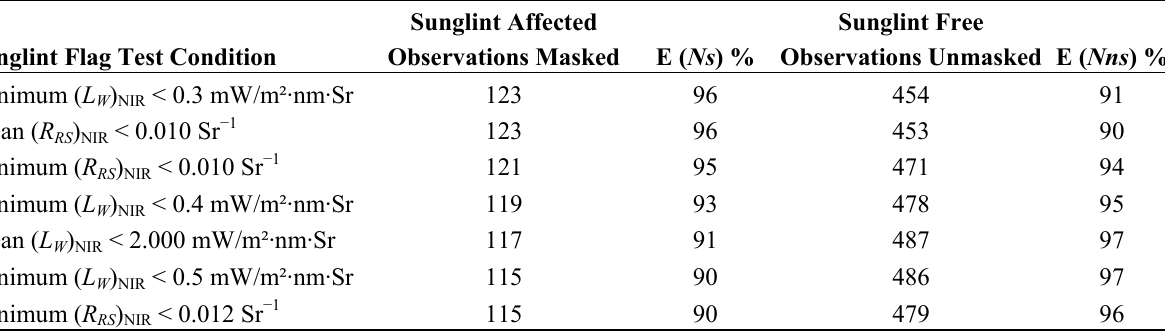
Table 1. A summarized evaluation of the most effective sunglint flagging ranked according to their performance in masking sunglint spectra in a reanalysis. To check for effectiveness, the percentage E ( Ns ) % and E ( Nns ) % was derived by dividing the number of spectra masked or unmasked by each condition with the actually number of spectra